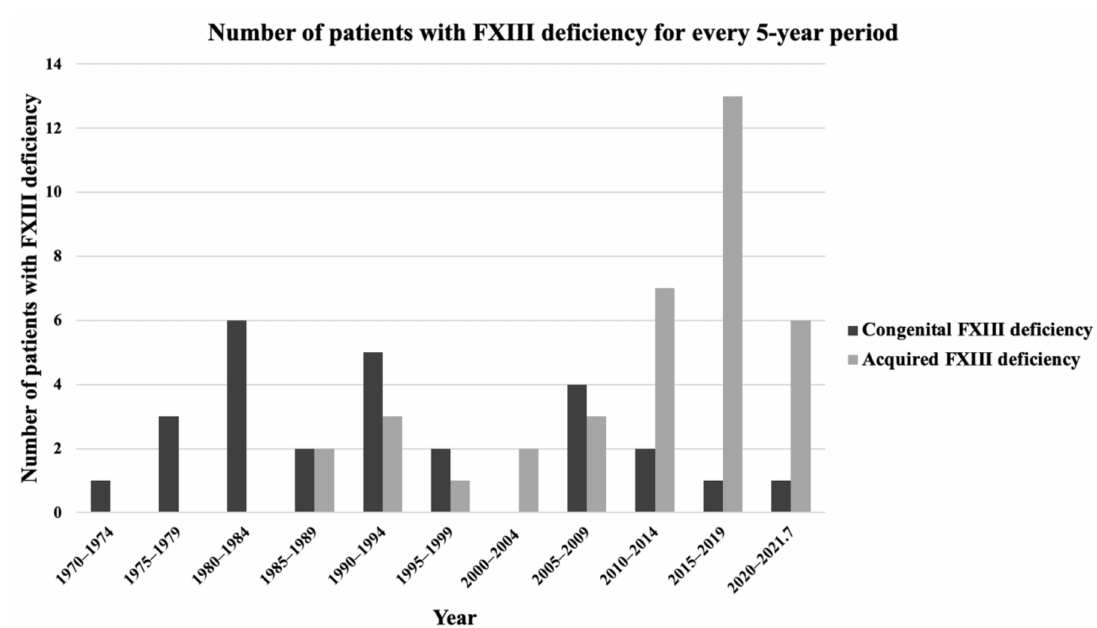
Figure 5. Distribution of factor XIII deficiency patients over time (5-year binned data). FXIII: factor